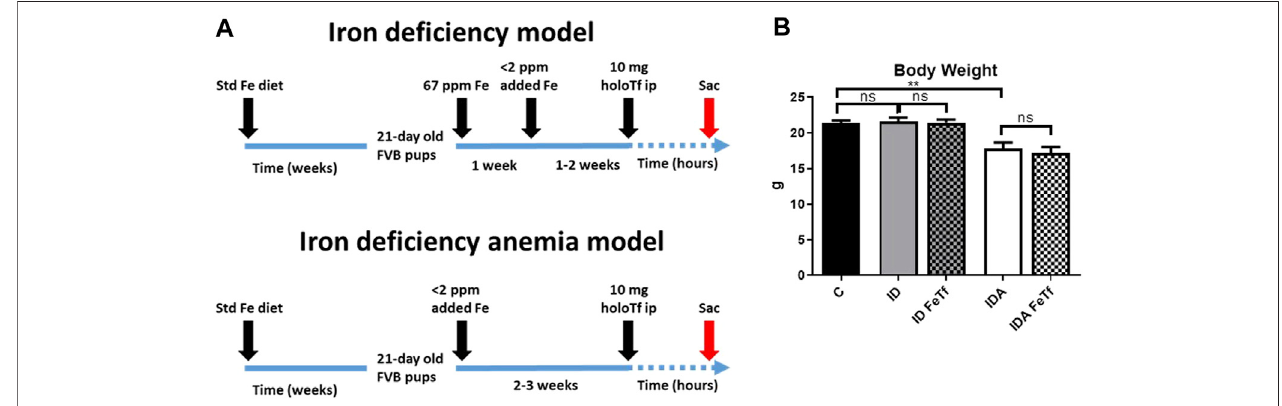
FIGURE1| Dietaryregimensproduce murine modelsofiron de fi ciencyand iron de fi ciency anemia. (A) Aschematicofthe dietary regimens used foreach model is shown.Ironde fi cientmice(ID)weregeneratedbyweaning21-dayoldmiceonto60 ppmFedietsuntil4 weeksofagethen2 ppmFedietsuntilsacri fi ce.Amurinemodel of iron de fi ciency anemia (IDA) was generated by feeding mice a 2 ppm Fe diet. At 5 – 6 weeks of age, both murine models were given 10 mg human holotransferrin (or carrier)byintraperitonealinjectionandsacri fi cedforanalysis6 hpost-injection. (B) Bodyweightsweremeasured.Controlmicefedastandard250 ppmFedietare includedfor reference. Forcontrol mice n =25, forID cohorts n = 16 – 20 and forIDA cohorts, n =6-7mice per group. ppm, parts per million. ppm, parts per million; data represented as mean (SEM).*, p < 0.05; ***, p < 0.005; ****, p < 0.001; ns, non-signi fi cant.